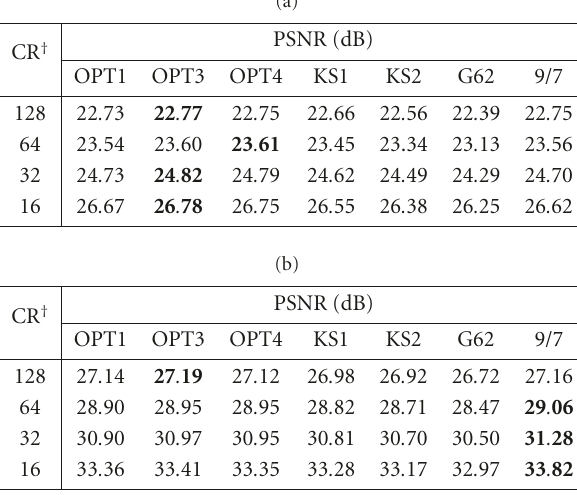
Table 6: Lossy compression results for the (a) sar2 and (b) gold images.